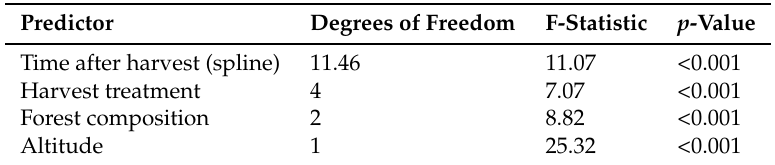
Table 2. F-test for the parameters of the selected model with temporal autocorrelation and a regression spline on